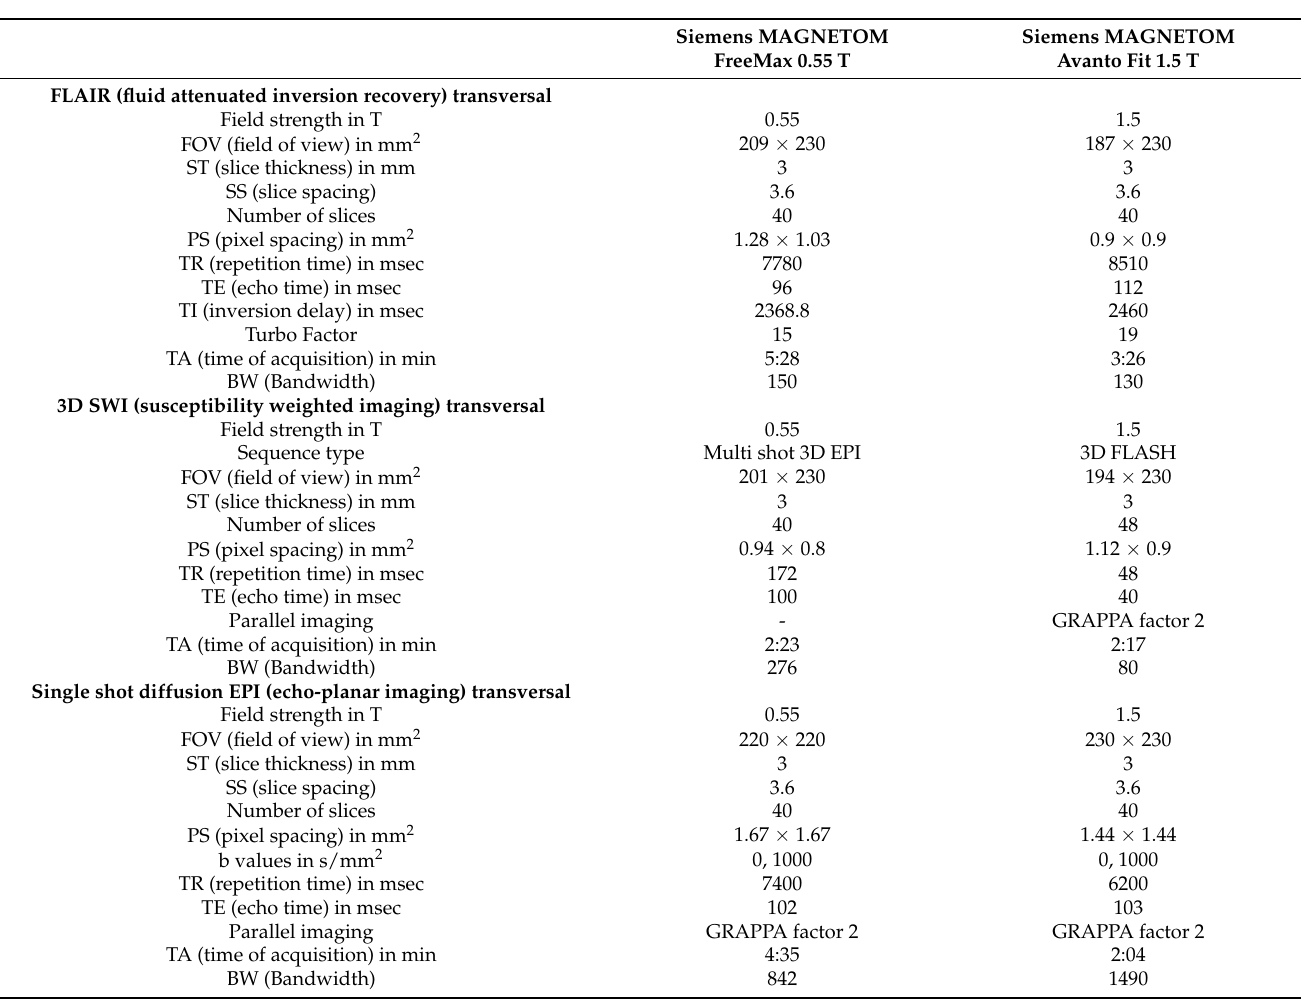
Figure 1. Workflow of patient selection and data acquisition. Table 1. Scan protocols, Siemens MAGNETOM Avanto FIT 1.5 T and Siemens MAGNETOM FreeMax 0.55